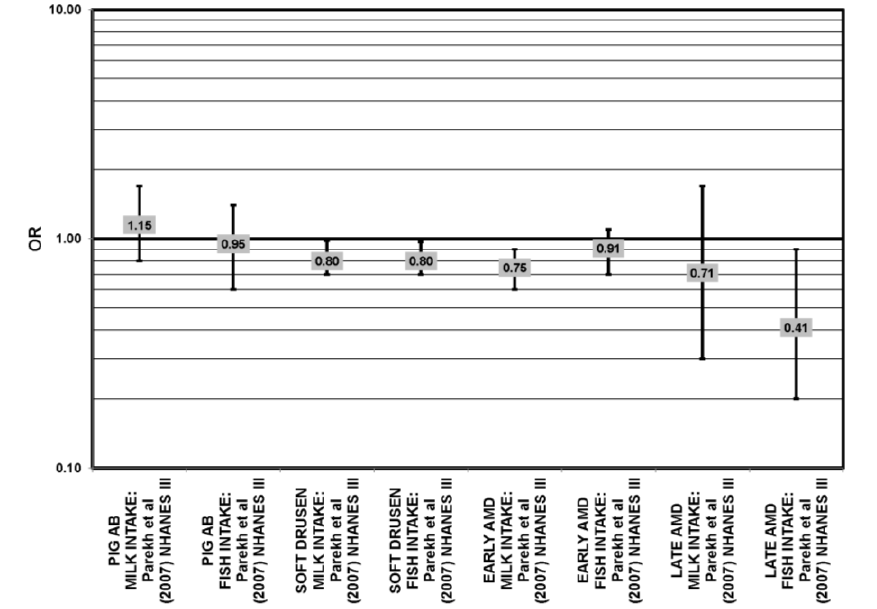
Figure 41. Odds ratio for early AMD, indicators of early AMD (PIG AB, SOFT DRUSEN) or advanced AMD; high vs. low intake of milk or fish in those at least 40 years of age: retrospective